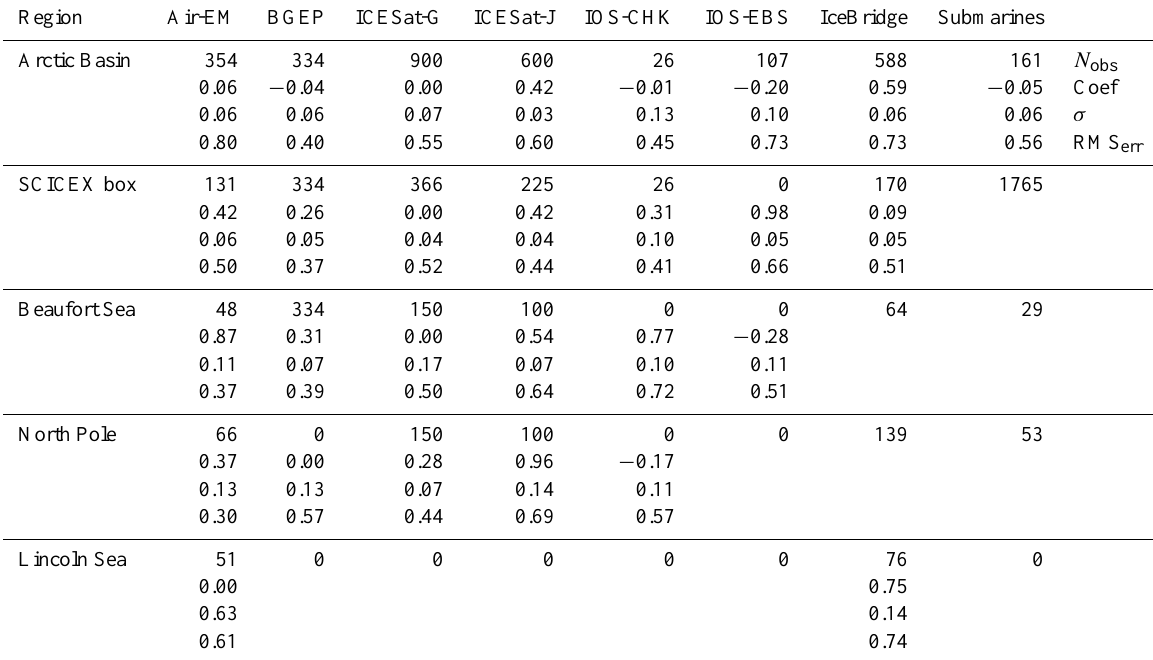
Table 4. Number of observations, the indicator coefficients and their σ values, and the RMS error for each source for each regional fit for the period 2000–2012. Region Air-EM BGEP ICESat-G ICESat-J IOS-CHK IOS-EBS IceBridge Submarines Arctic Basin